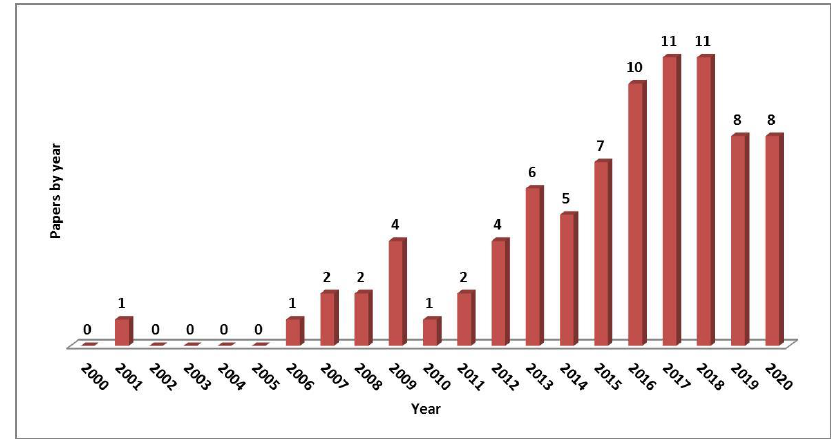
Figure 1. Graph of scientific papers published per year in the period 2000–2020 regarding nanoparticles used to consolidate different artifacts. From Scopus (https://www.scopus.com).